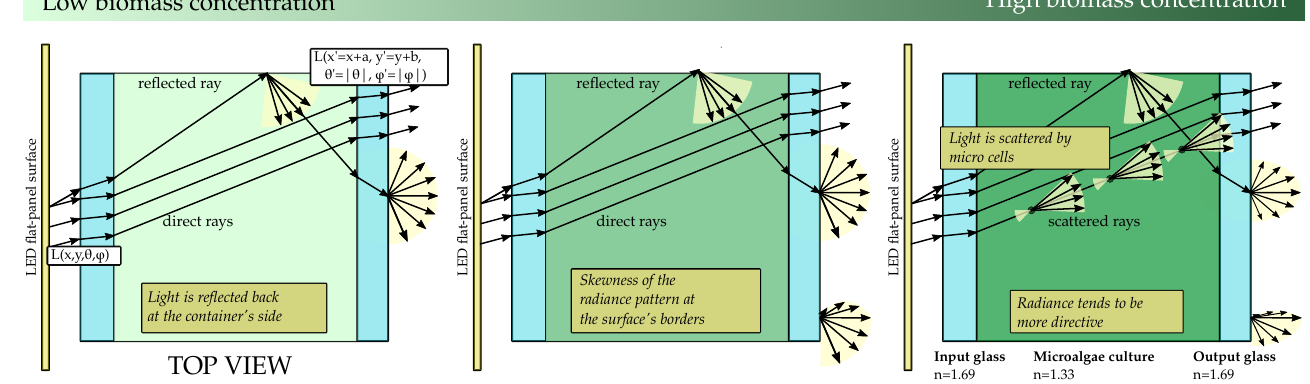
Figure 2. Layered version of the